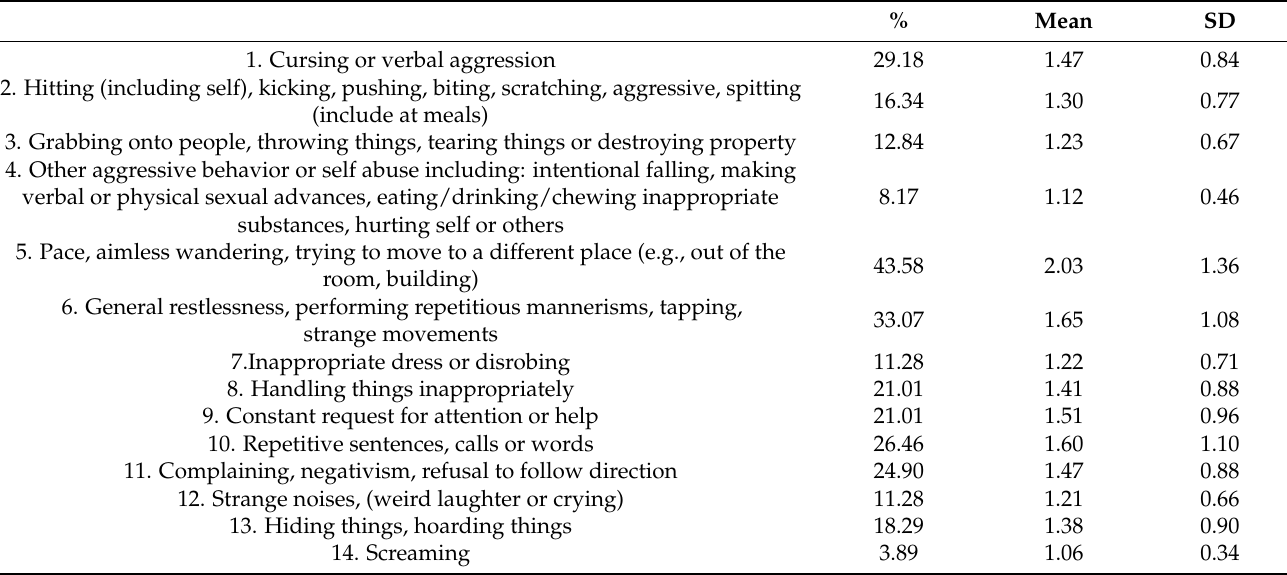
Table 2. The frequency and mean score in individual items of CMAI.